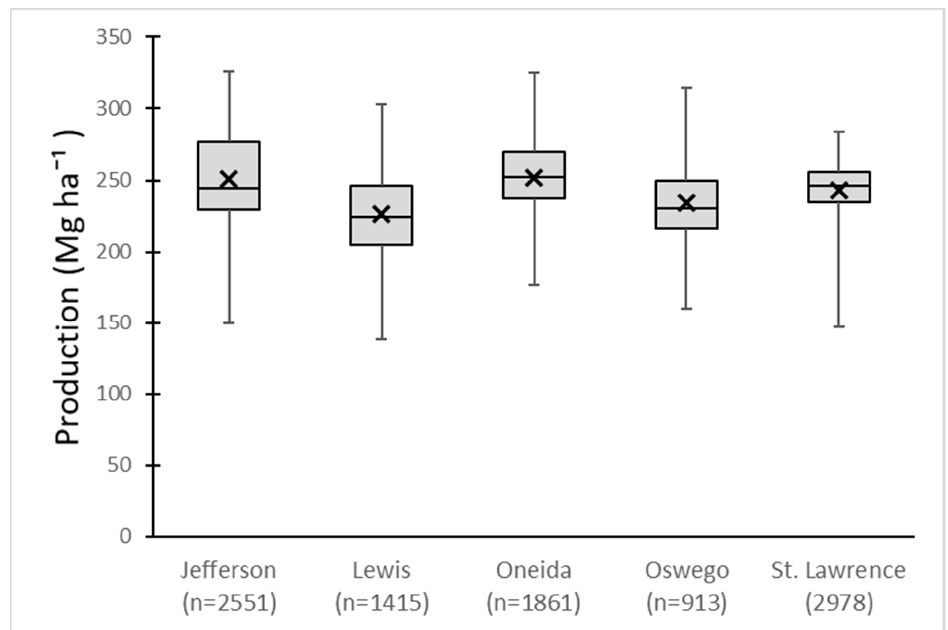
Figure 4. Distribution of yield estimates over seven rotations based on National Commodity Crop Productivity Index (NCCPI) indices from the Soil Survey Geographical Database (SSURGO) soil data layer for parcels in five counties. The lines in boxes are 25th percentile, median, and 75th percentile. The cross markers represent mean values. The whiskers are minimum and maximum values.